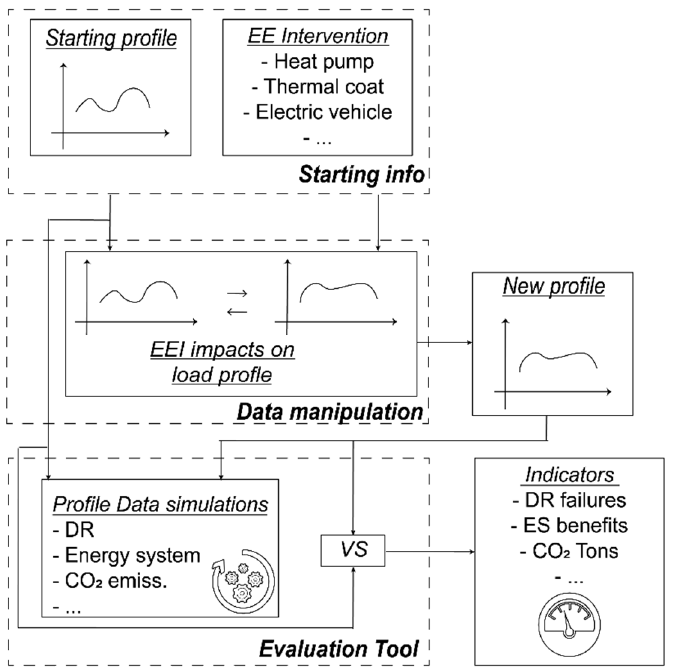
Figure 1. Evaluation tool of energy efficiency.